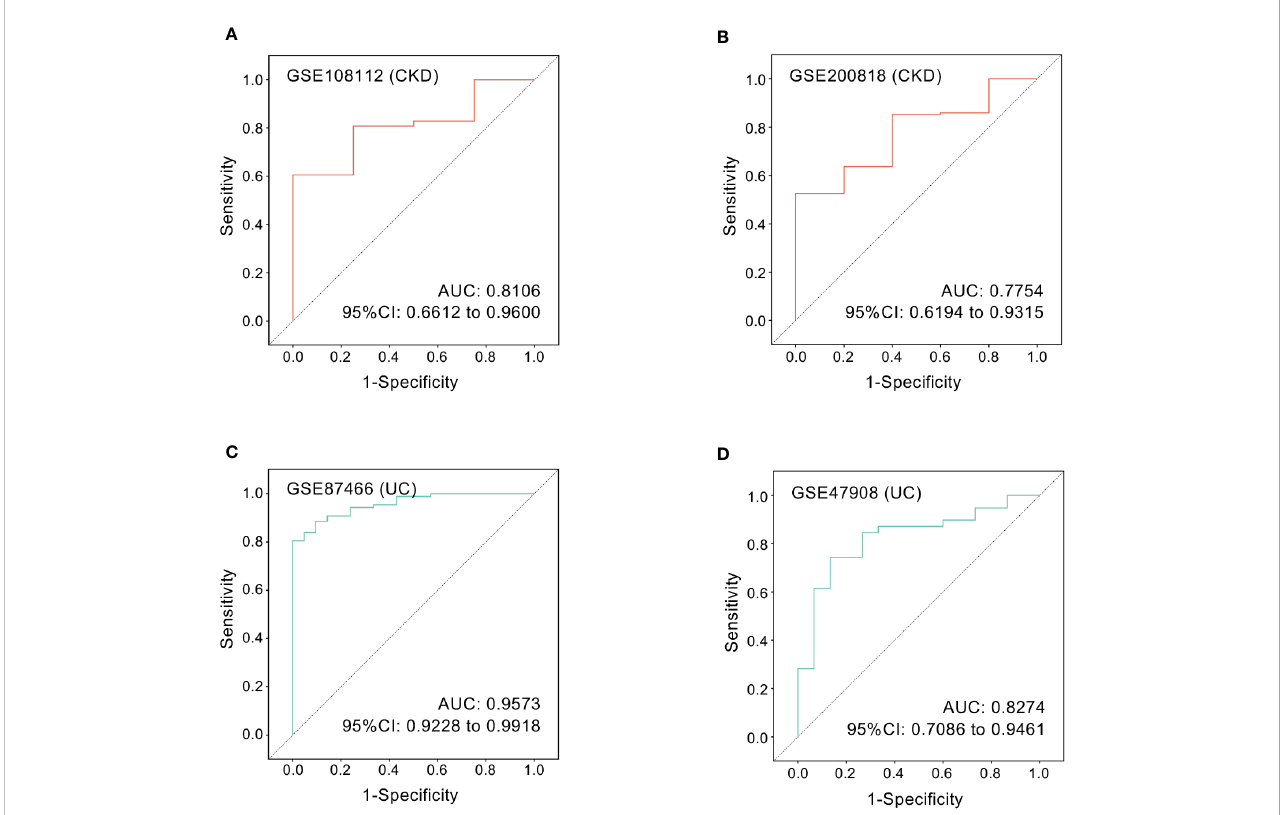
FIGURE 8 ROC curves of the hub gene in CKD and UC. ROC curves were drawn to evaluate the accuracy of ICAM1 in diagnosing CKD (A, B) or UC (C, D) . ROC: receiver operating characteristic; CKD, chronic kidney disease; UC, ulcerative